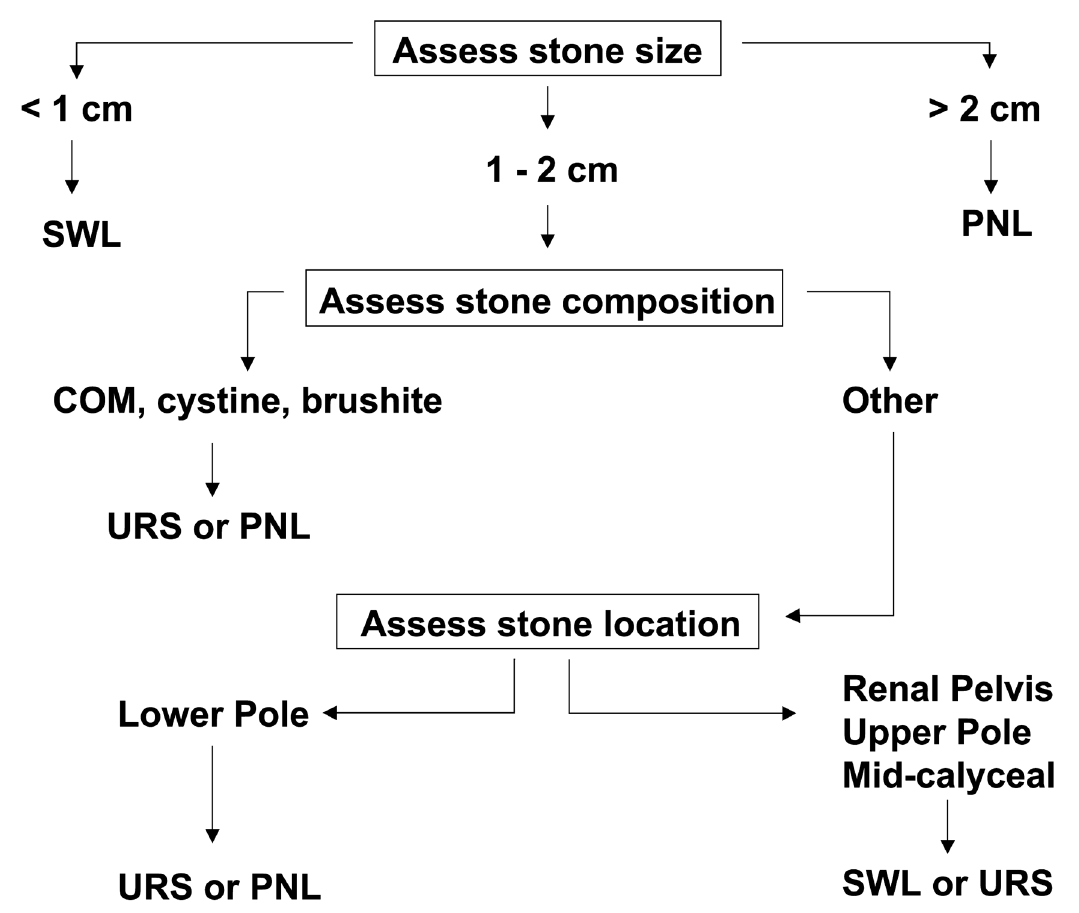
Figure 1 - Algorithm for a rational approach to contemporary management of renal